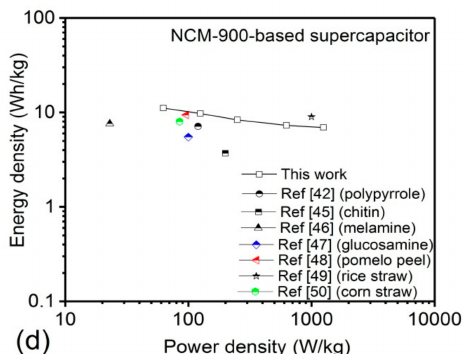
Figure 8. ( a ) CV curves of NCM-900 at di ff erent scan rates, ( b ) GCD curves of NCM-900 at di ff erent current densities, ( c ) cycling stability performance at a current density of 5 A / g to 2000 cycles for NCM-900-based supercapacitors in 6 M KOH electrolyte (inset graph is the specific capacity of NCM-900 at di ff erent current densities), and ( d ) Ragon plots for NCM-900-based supercapacitor with